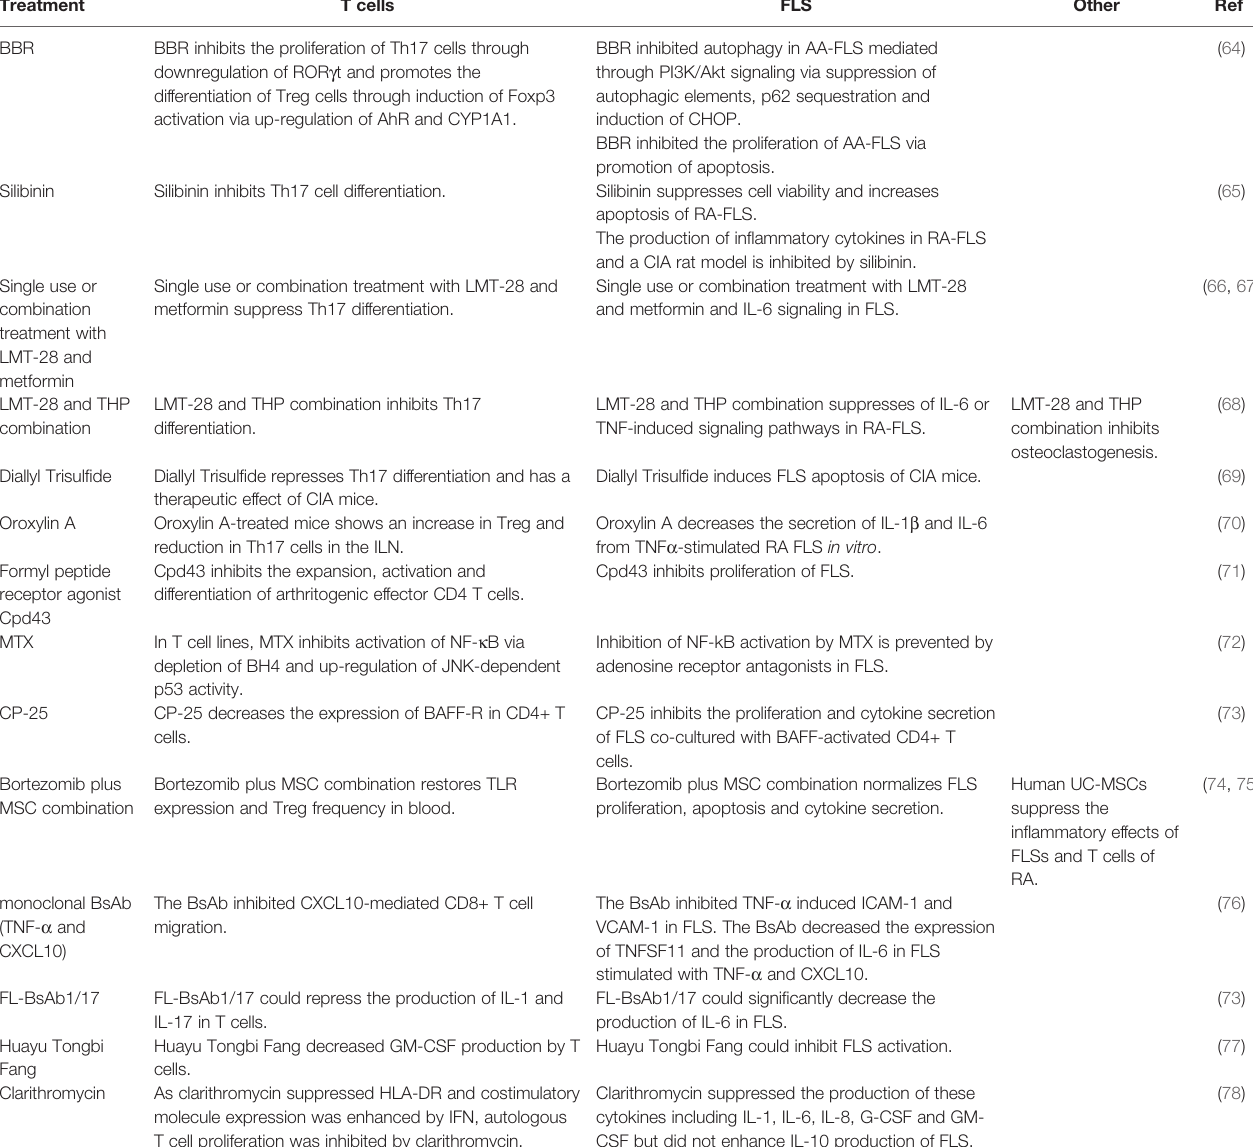
TABLE 1 | The medicinal treatment regimens that can affect the functions of both T cells and FLS in RA. Treatment T cells FLS Other